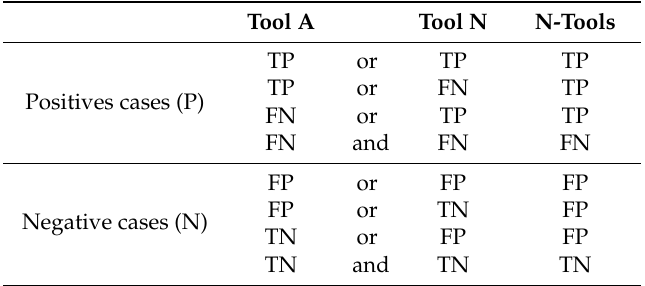
Table 5. Logic applied to the combination of two